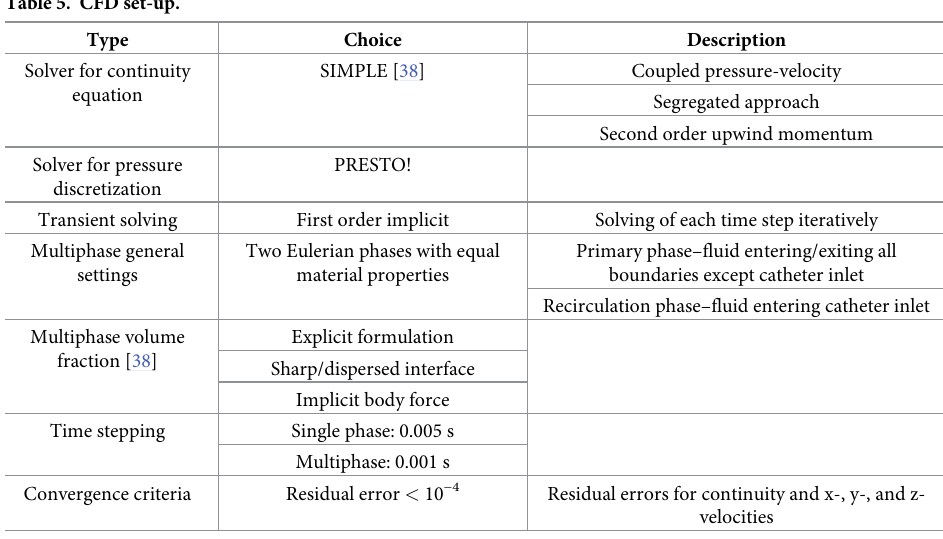
Table 5. CFD set-up.